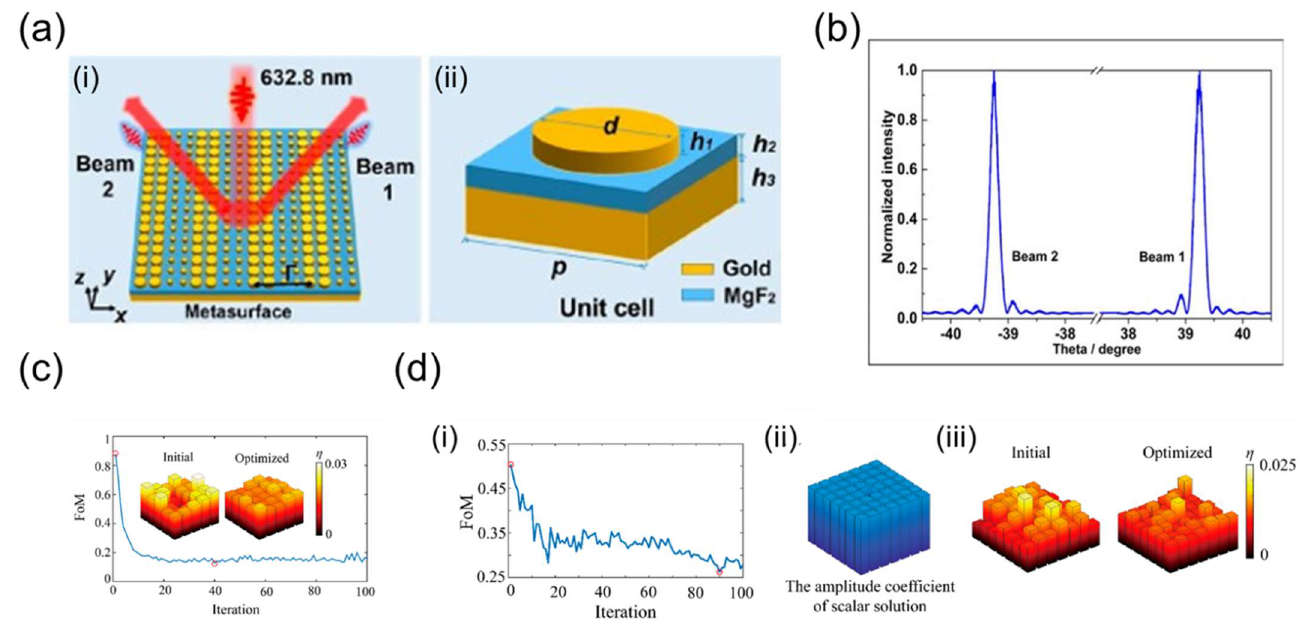
Figure 12. ( a ) Schematic diagram of the metasurface-based visible beam splitter ( i ) and unit cell ( ii ). Reprinted with permission from [120]. Copyright 2018 American Chemical Society. ( b ) The measured distribution of light intensity at different angles at normal incidence. Reprinted with permission from [120]. Copyright 2018 American Chemical Society. ( c ) FoM as an iterative function to optimize beam splitters of 5 × 5, where FoM is the figure of merit for the uniformity of diffraction